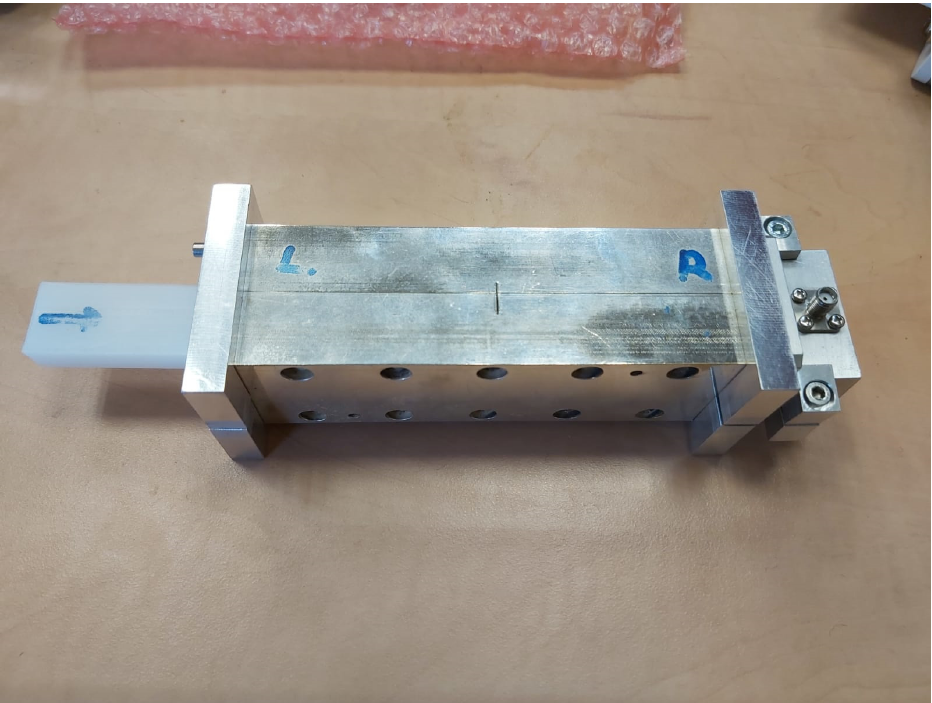
Energies 2021 , 14 , x FOR PEER REVIEW Figure 7. The container and waveguide for the 8–12 GHz frequency range. Figure 7. The container and waveguide for the 8–12 GHz frequency range.